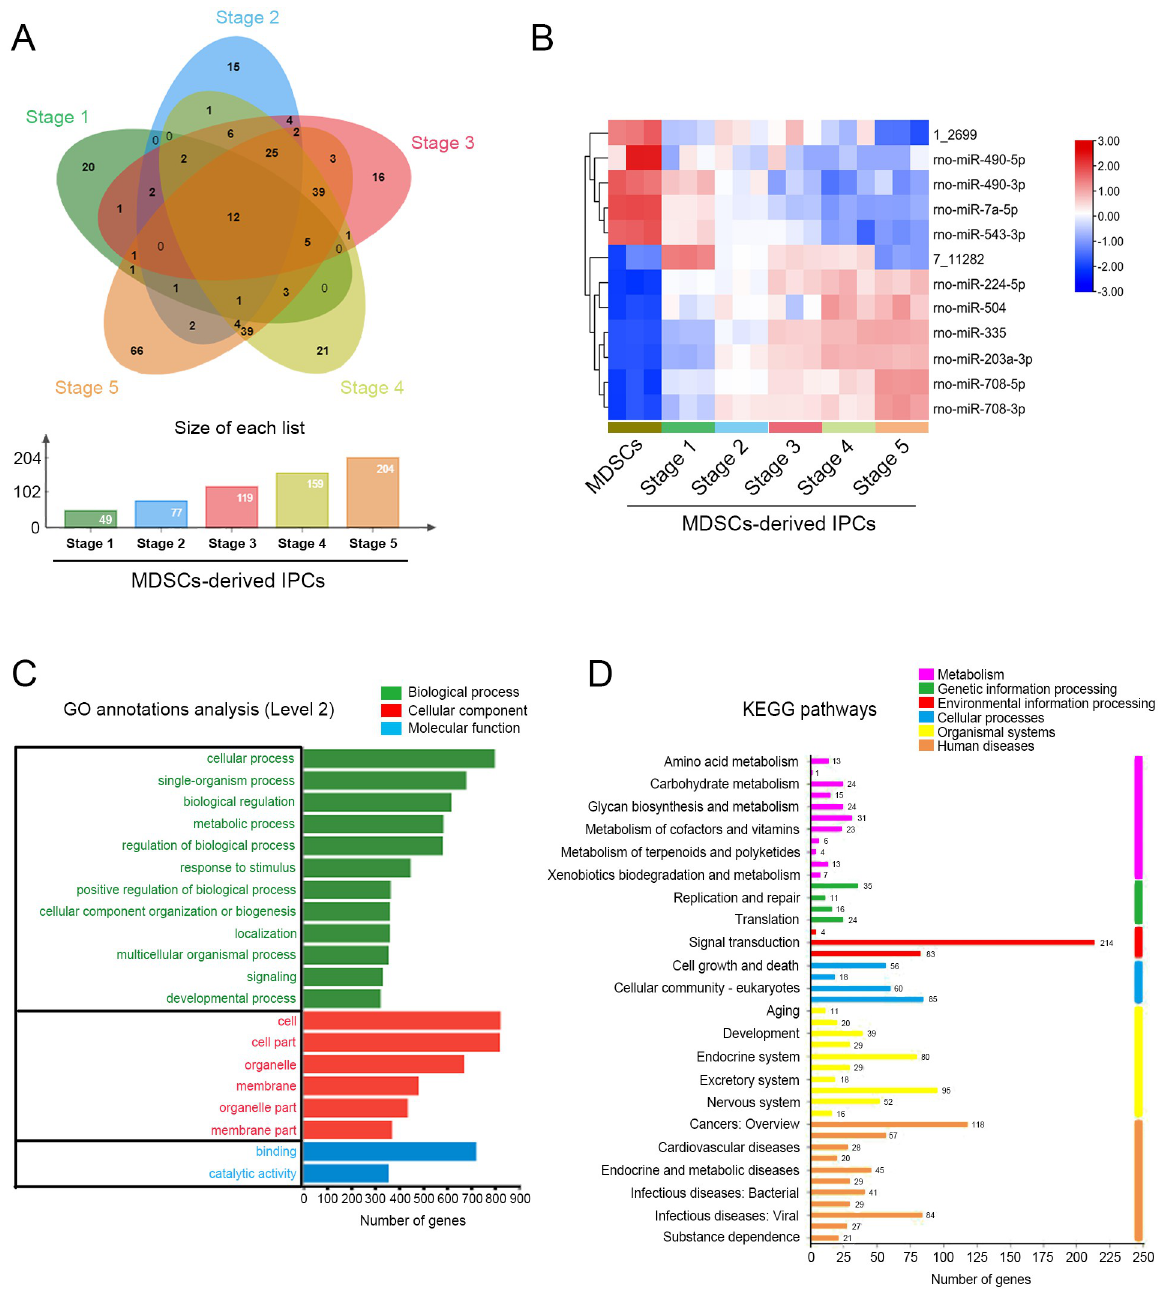
Fig 3. Differentially expressed miRNAs (DEmiRNAs) profiling and bioinformatic analysis. (A) The unique and common DEmiRNAs at stage 1–5 of MDSCs-derived IPCs differentiation were visualized by a Venn diagram. (B) The expression of 12 common DEmiRNAs from stage 1 to 5 was shown by a heatmap. (C) The functions of target genes of DEmiRNAs were enriched by gene ontology (GO) analysis. (D) The functions of target genes were enriched through KEGG pathway analysis. https://doi.org/10.1371/journal.pone.0266609.g003 shown in Fig 3B, the expression of rno-miR-490-5p, rno-miR-490-3p, rno-miR-7a-5p, and rno-miR-543-3p showed a decreasing trend from stage 1 to stage 5 of differentiation. In con- trast, the expression of rno-miR-224-5p, rno-miR-504, rno-miR-335, rno-miR-203a-3p, rno- miR-708-5p, and rno-miR-708-3p presented an increasing trend. These DEmiRNAs were